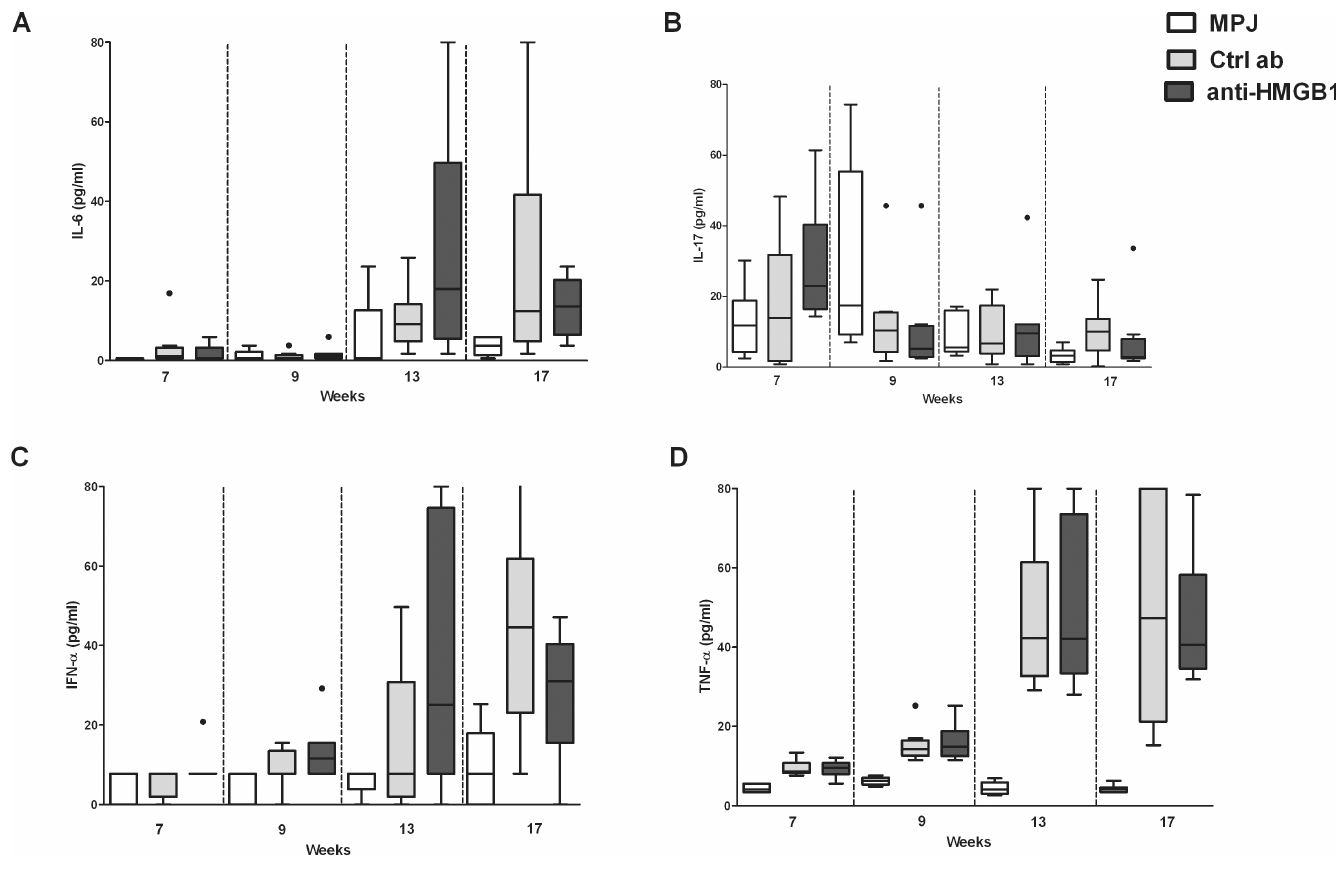
Figure 3. Anti-HMGB1 mAb treatment of MRL/lpr mice does not affect plasma levels of proinflammatory cytokines. Plasma levels of the cytokines IL-6 (A), IL-17A (B), IFN- α (C) and TNF- α (D) were measured by multiplex in MRL/MPJ and MRL/lpr mice at wks 7, 9, 13 and 17. Box and whiskers plot, median and interquartile range are shown for n = 6–8 mice per group. Separate dots indicate